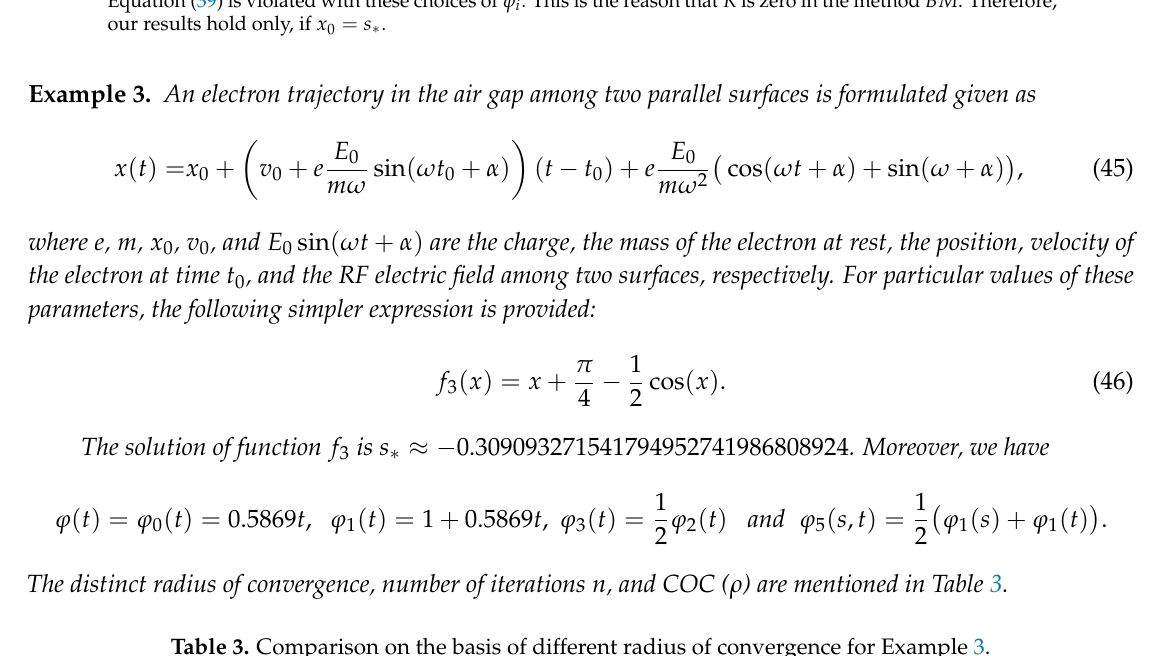
Table 3. Comparison on the basis of different radius of convergence for Example